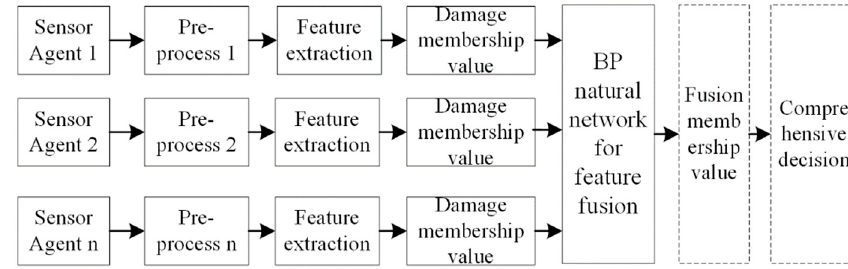
Figure 10. Data fusion framework for track damage detection.